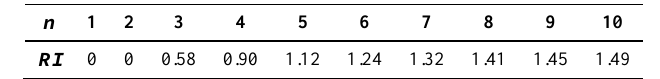
Table 9. Consistency Ratio Measurement with Random Indices ( n = 1 to 10) [45,